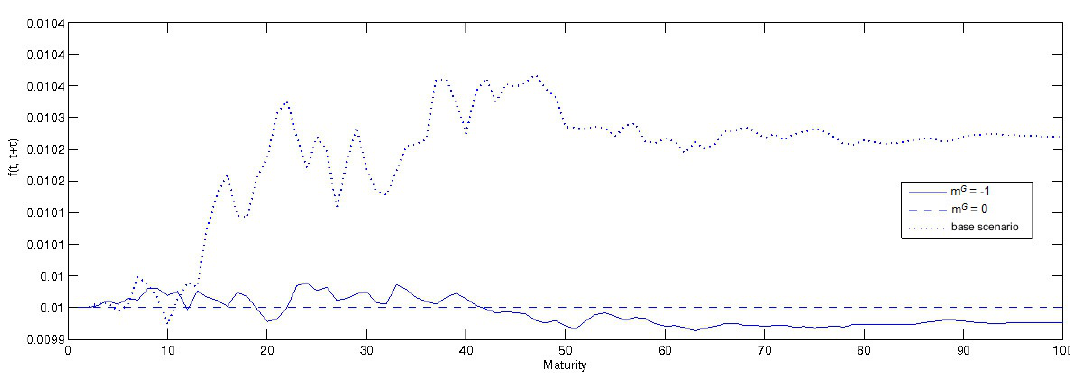
Figure 7. Performance of the instantaneous forward rate to various government